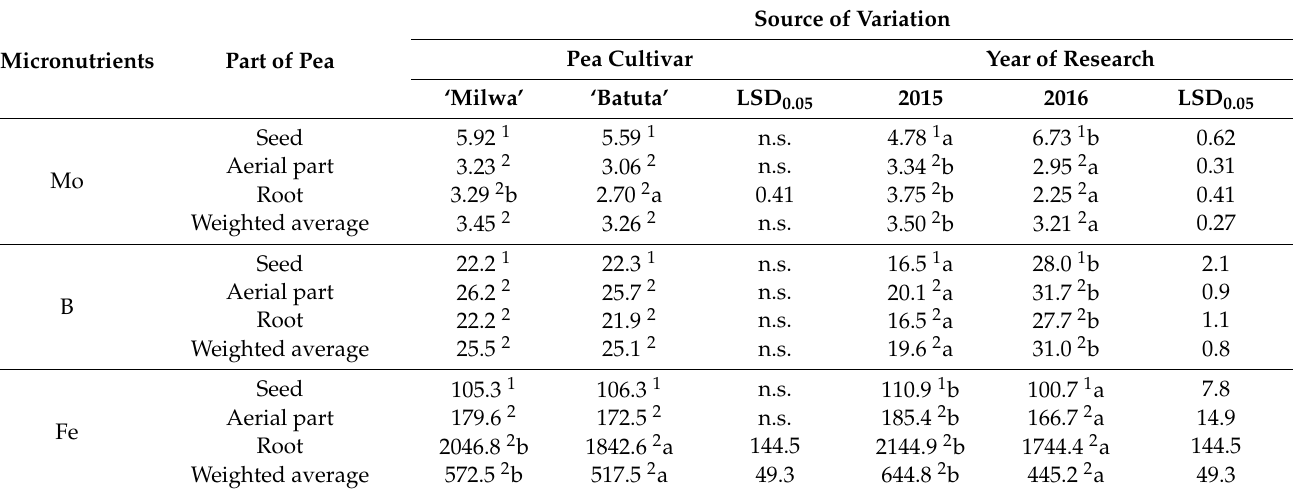
Table 4. Mo, B, and Fe content in dry mass of pea, mg · kg − 1 DW.